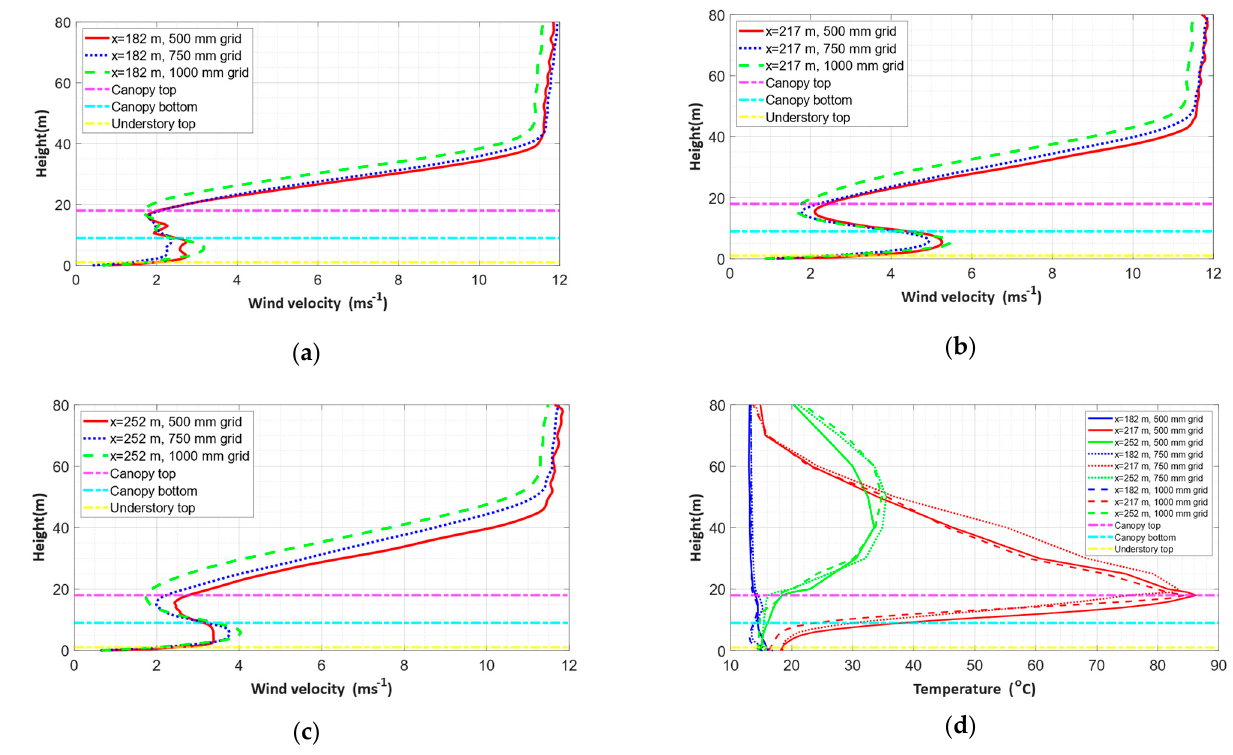
Figure 10. ( a – c ) The graphical comparison of time-averaged velocity and ( d ) time-averaged temperature for 500, 750 and, 1000 mm grid sizes at x = 182, 217 and 252 m.